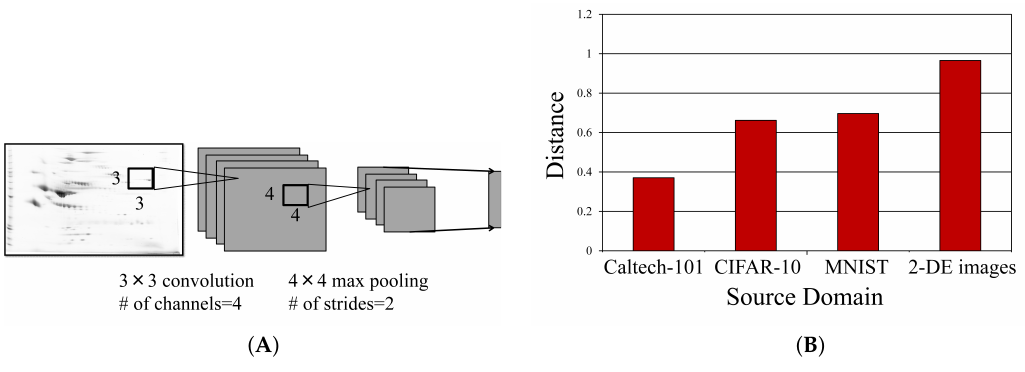
Figure 5. ( A ) CNN structure. ( B ) Distances of different source domains. Table 4. Classification performance when using CNN. The red bold is the best performance of each evaluation. The bold is the second best performance.